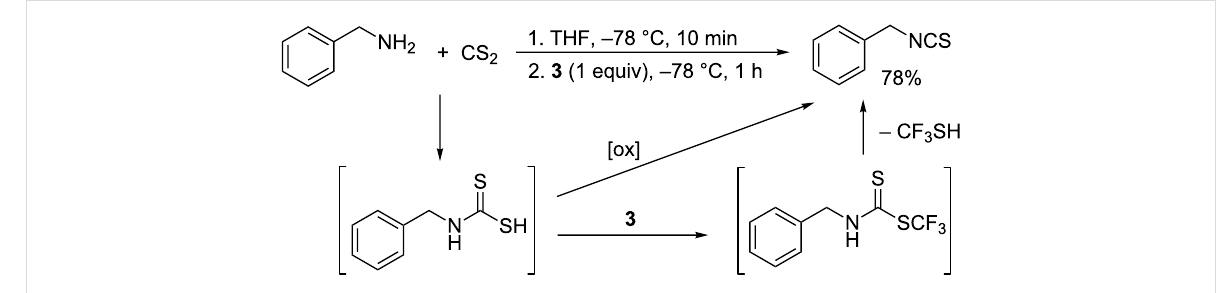
Scheme 3: Formation of benzyl isothiocyanate in a reaction with benzylamine.